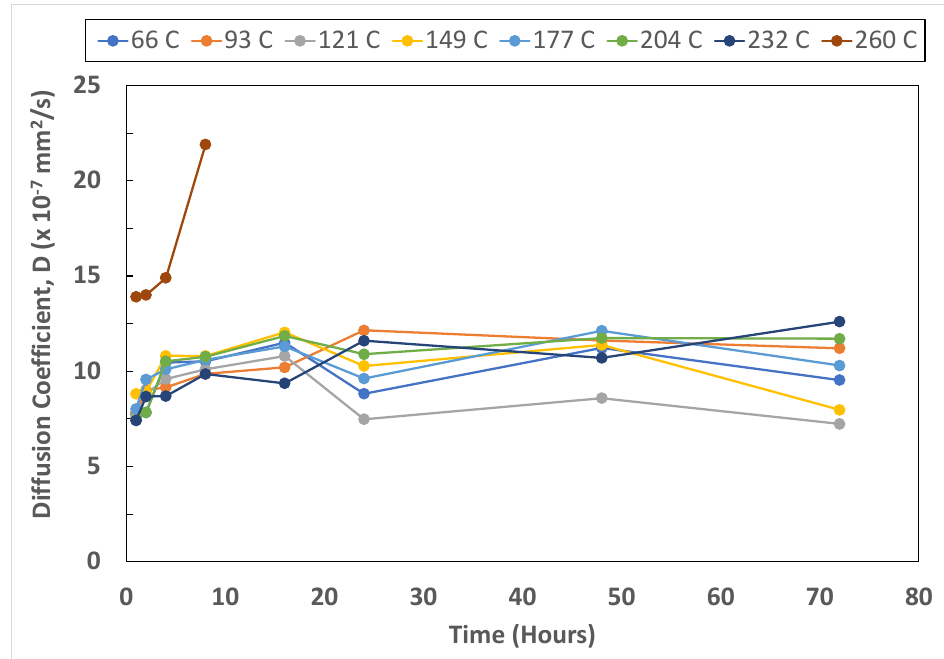
Figure 2. Diffusion coefficients as a function of time and temperature of prior thermal aging.